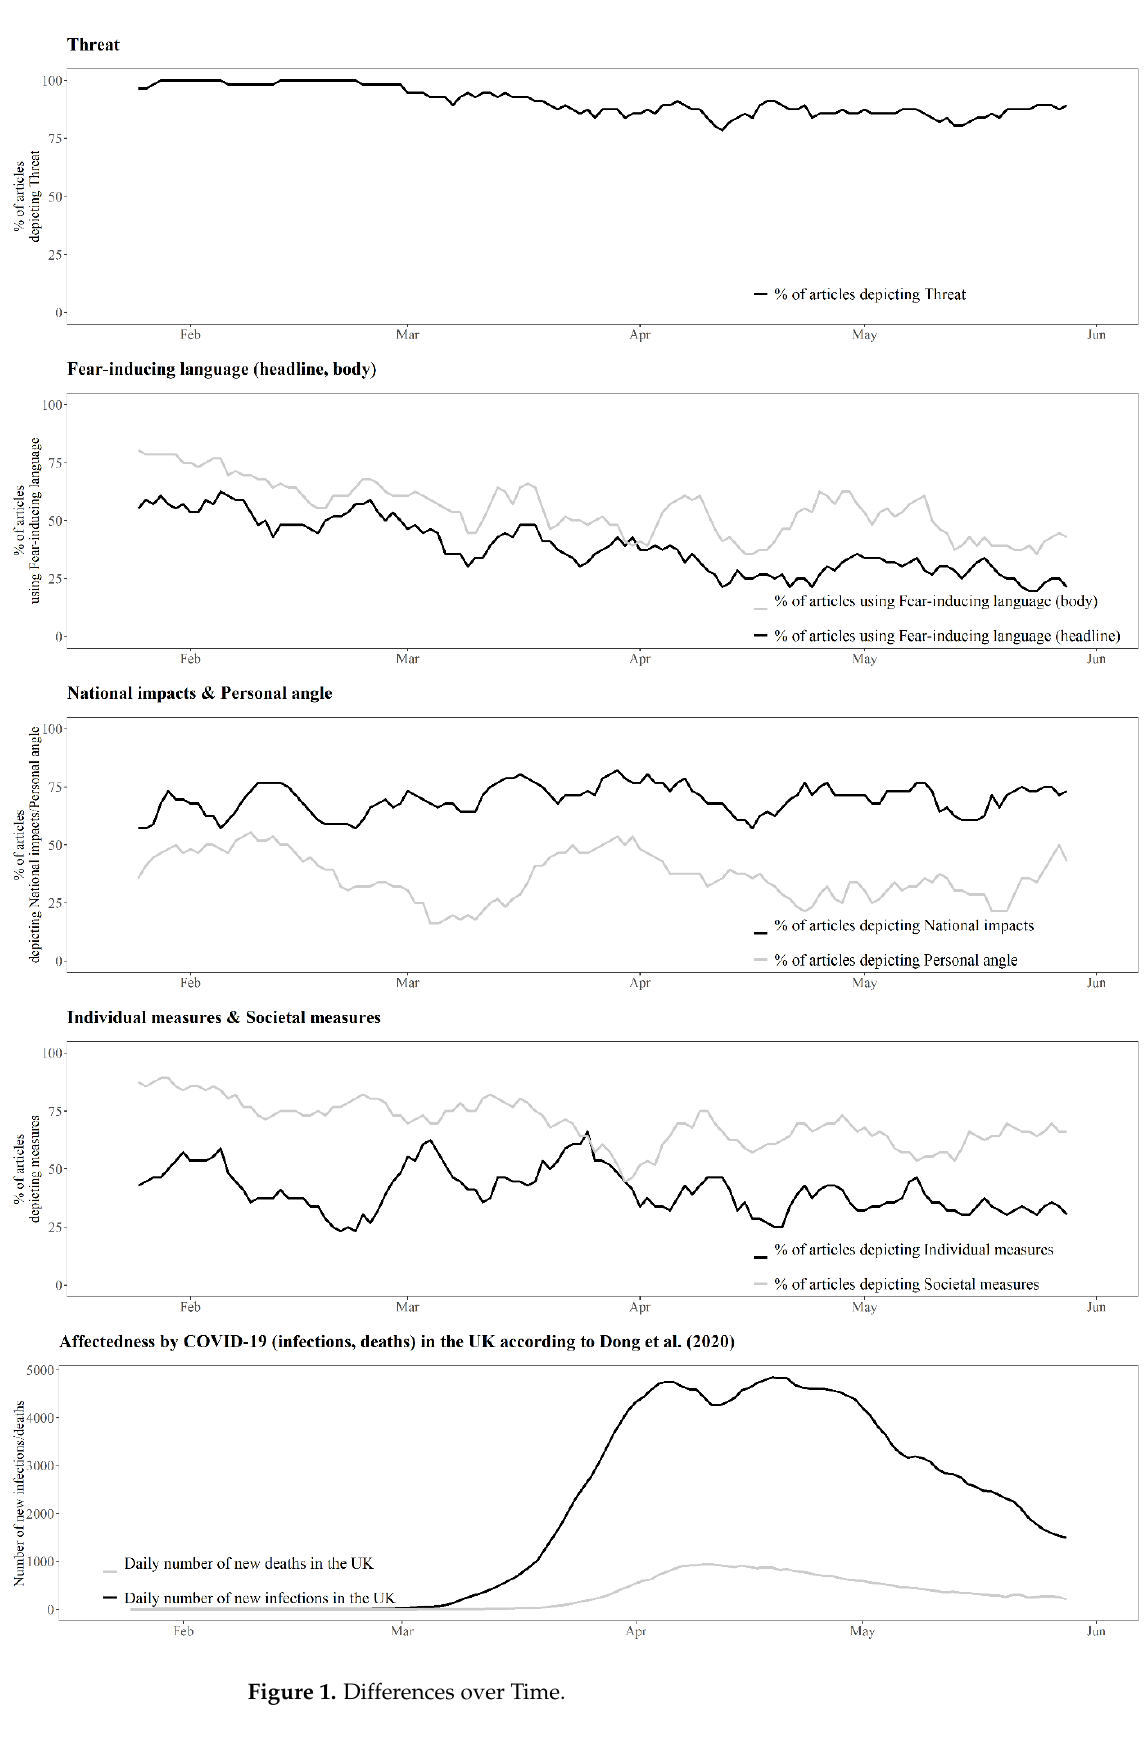
Figure 1. Differences over Time.